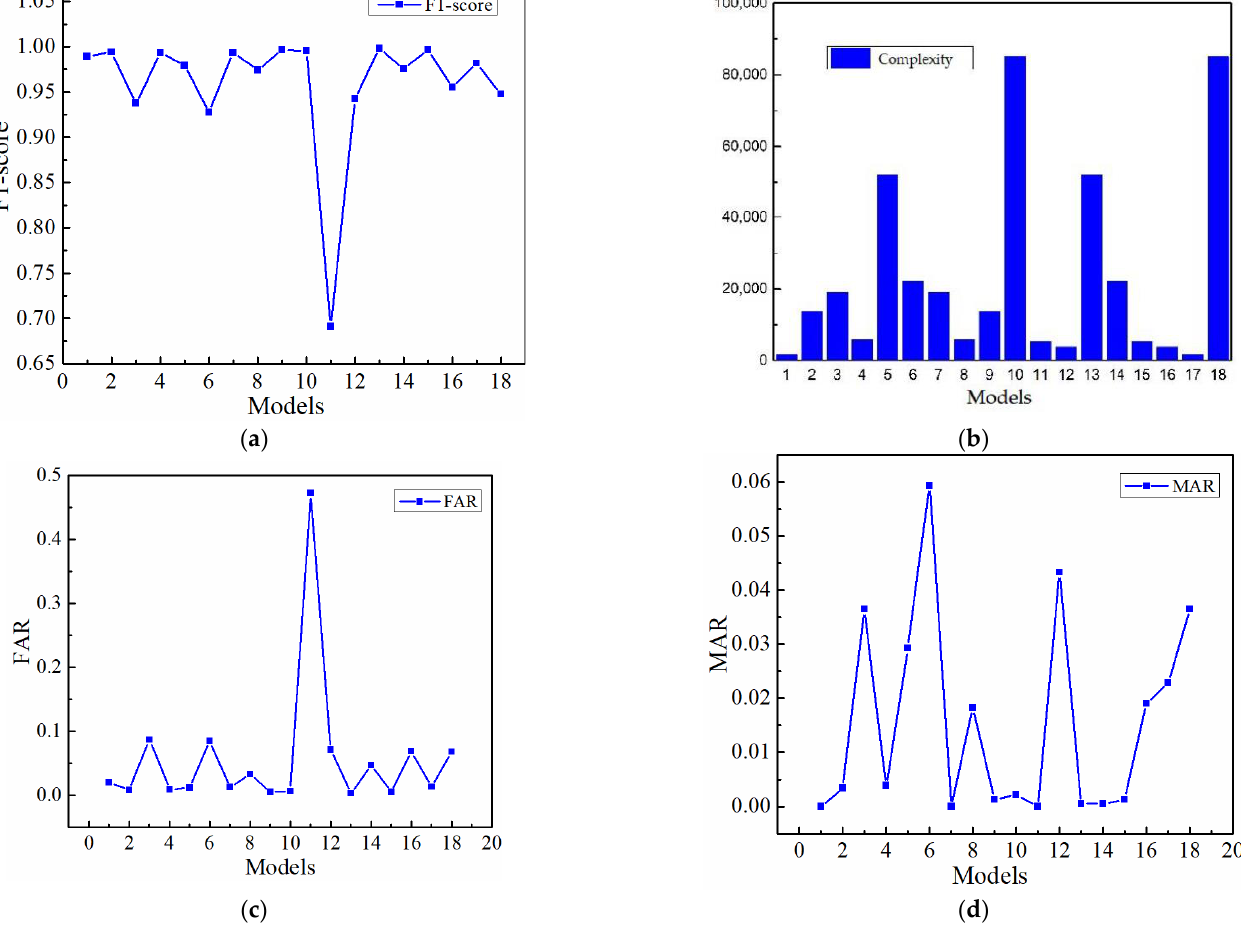
Figure 7. Different evaluation indexes of classification model. ( a ) F1 of each model; ( b ) Complexity of each model; ( c ) FAR of each model; ( d ) MAR of each model.